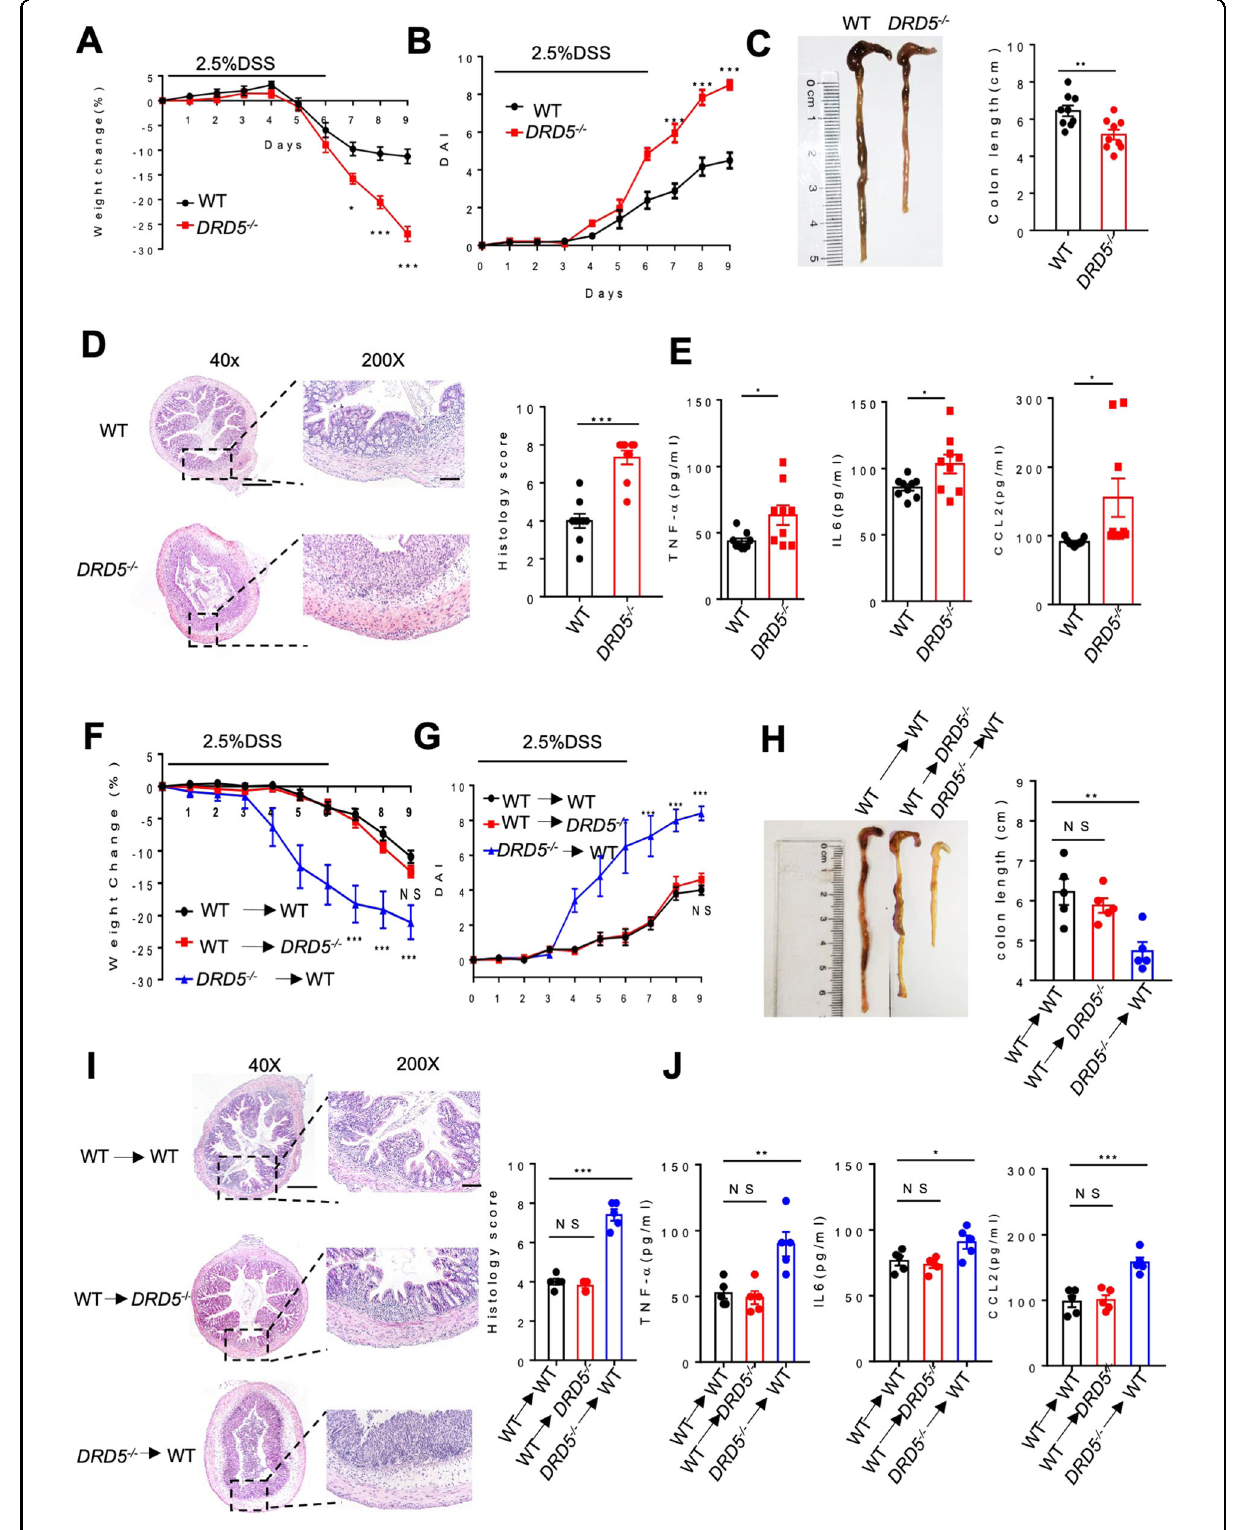
Fig. 2 (See legend on next